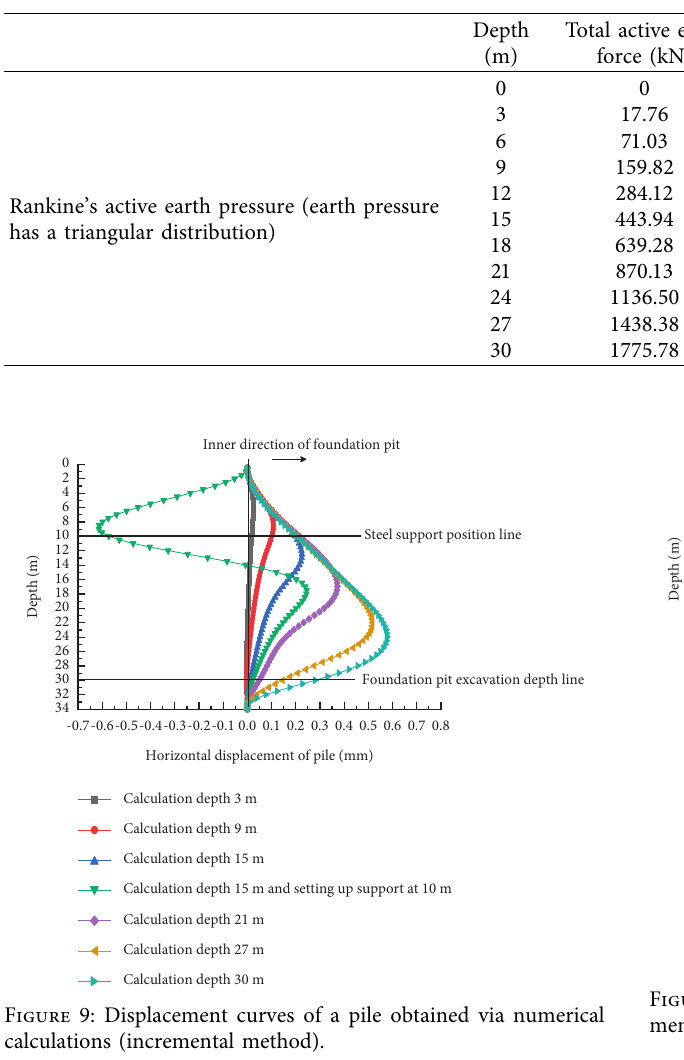
Table 2: Calculation of Rankine’s active earth pressure increment.